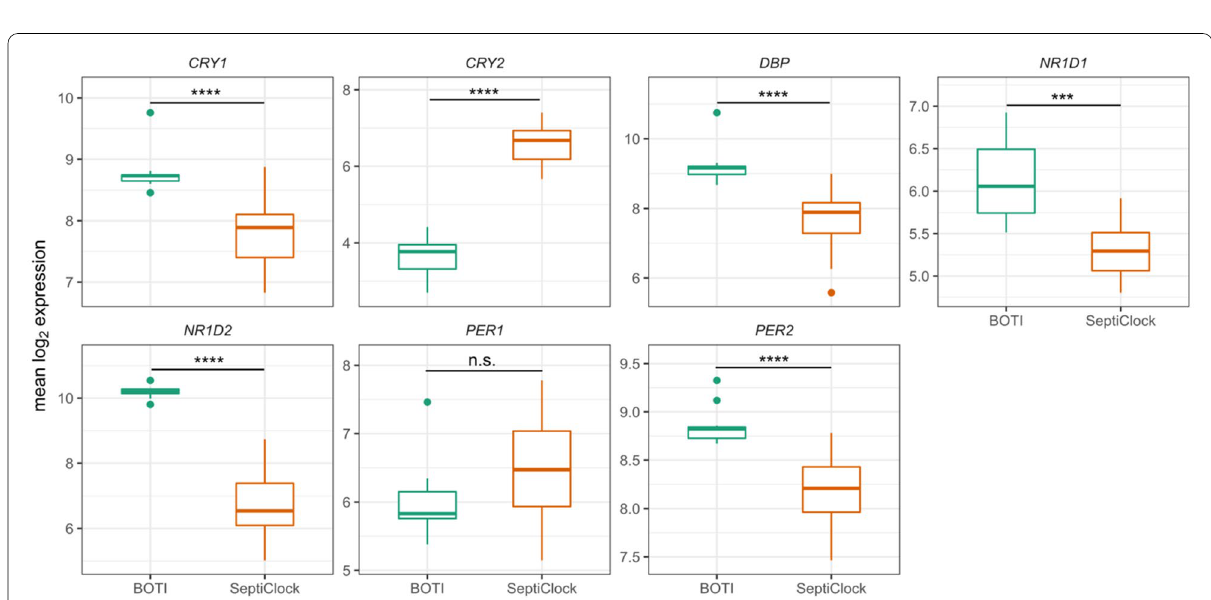
Fig. 5 Comparison of average clock gene expression of the 7 common clock genes in septic shock patients and BOTI subjects. The log 2 gene expression average across time points for each septic shock patient ( N BOTI study. P‑values for the significance of the difference are based on the non‑parametric Wilcoxon rank‑sum test. **** p < 0.0001, *** p < 0.001, n.s. p >